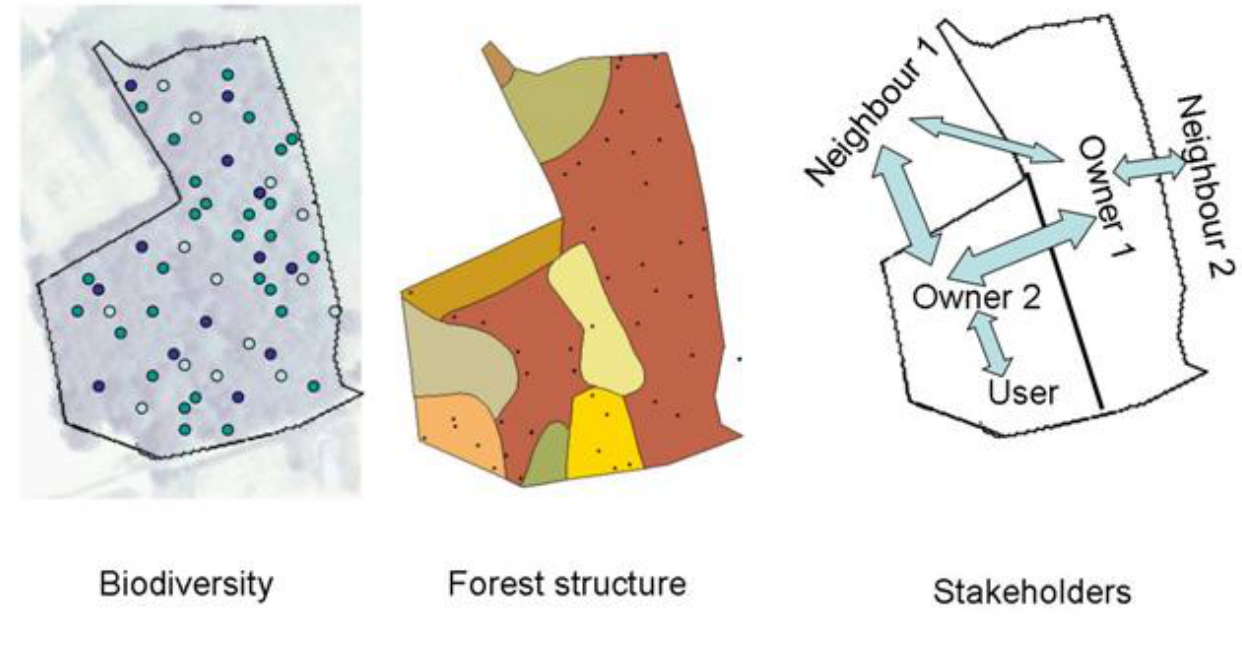
Fig. 4. From ecological processes to the stakeholders’ practices. A part of the interdisciplinary research project carried out on the same woodlots of southwestern France: 1) on the left, ecological studies of biodiversity, with plots identifying locations of individual birds of different species represented by different colors, 2) in the middle, forestry studies of woodlot structure, represented by polygons of different tree composition and structure, and by dots for valuable standard trees, and 3) on the right, ethnological studies of stakeholders’ motivations and relationships, represented by the three